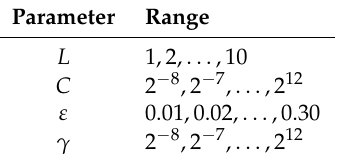
Table 1. Ranges for the grid of the parameters L , C , ε and γ for the radial and linear kernel. Parameter Range L 1,2, . . . ,10